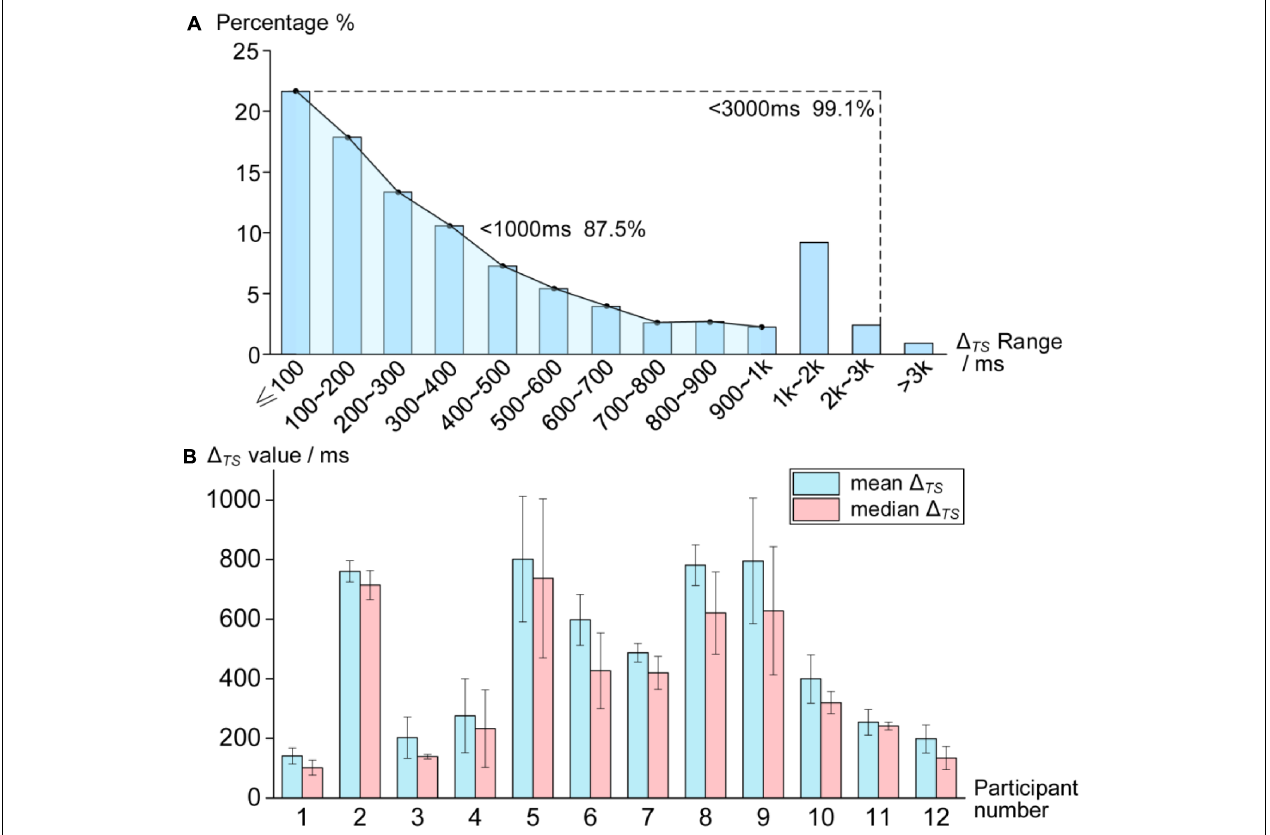
FIGURE 5 | Overall performance of (cid:49) TS . (A) Proportion of different (cid:49) TS ranges for all correct trials of four sessions. (B) Mean and median of (cid:49) TS for correct trials of four sessions for each participant. Error bars indicate ± SD